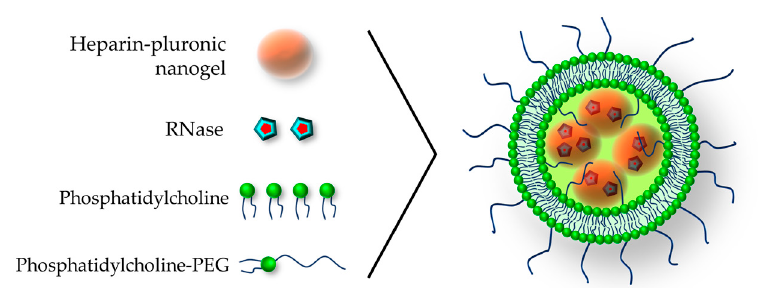
Figure 10. The PEGylated nanolipogel containing heparin-pluronic nanogel loaded with RNase. Adapted by permission from Springer Nature: Macromolecular Research [81], Copyright 2015.